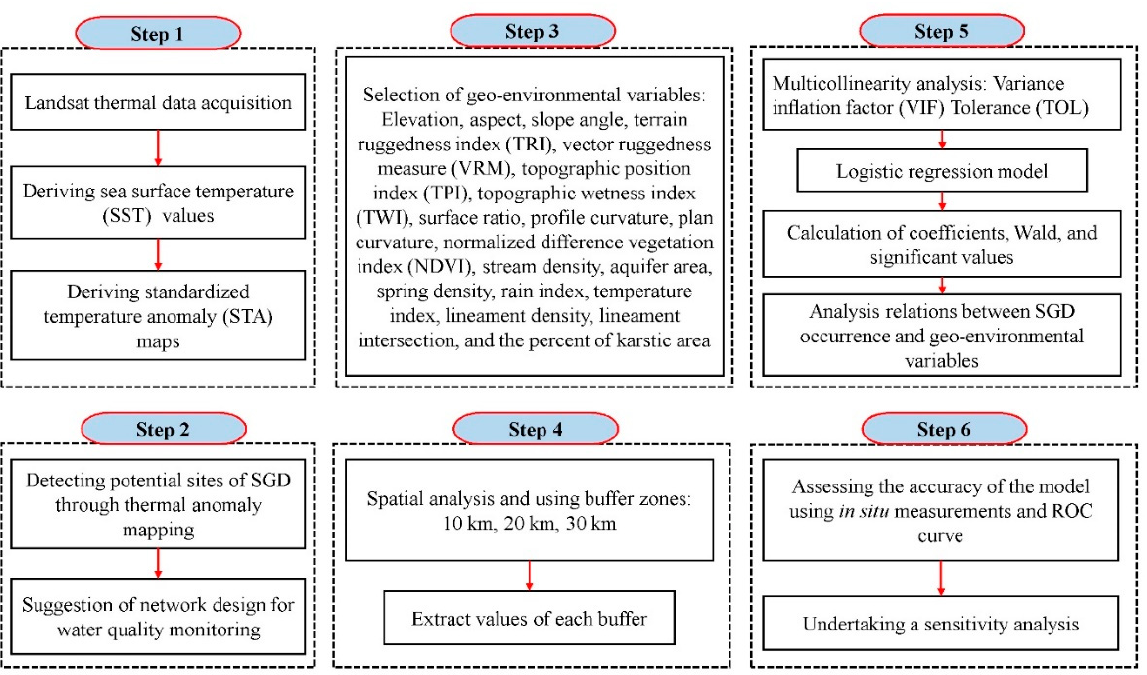
Figure 2. Flowchart of the study.